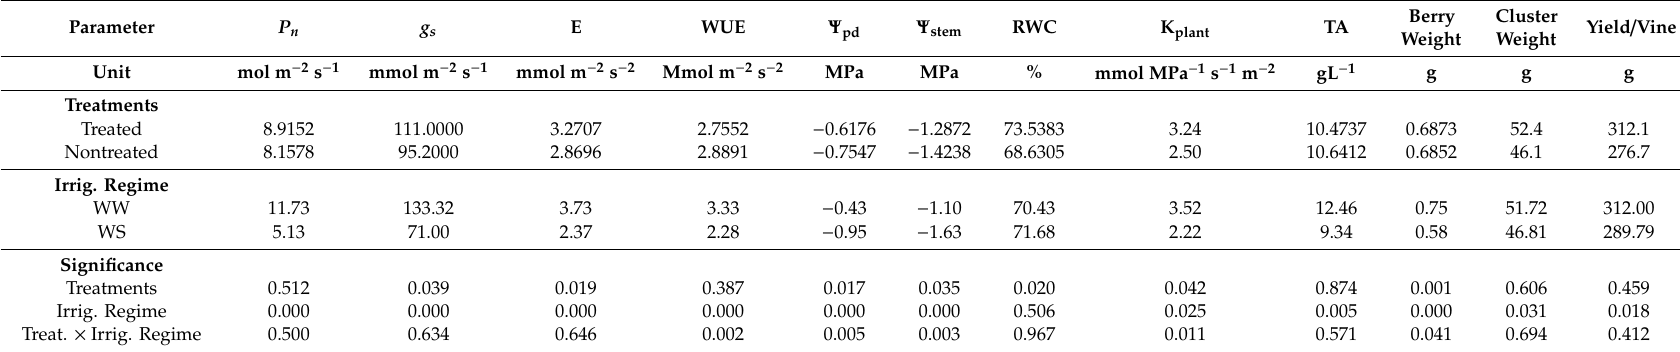
Table 2. Two-way ANOVA ( p < 0.05) for eco-physiology, chemical features of the berry and productivity parameters in V. vinifera treated with A. nodosum extract (SWE) and untreated plants (CTRL), under two irrigation regimes (WW, well-watered; WS, water stressed). Parameter P n Unit Treatments Treated Irrig. Regime